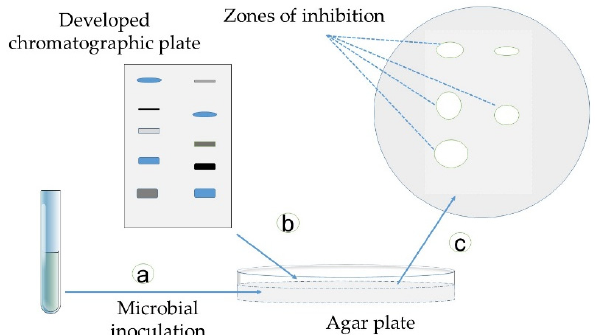
Figure 10. Schematic presentation of the contact bioautographic method: ( a ) microbes are inoculated on an agar plate; ( b ) a developed chromatographic plate is flipped over an agar plate to create a chromatographic image and transfer the active compounds, and inoculated plates are incubated for 48 h at 37 ◦ C, and finally, ( c ) the zones of inhibition can be seen on the agar around the active antimicrobial compounds (adapted from